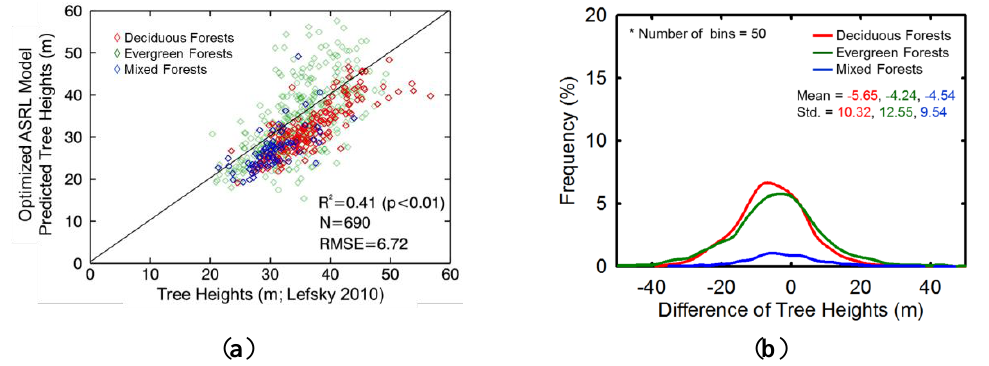
Figure 8. Inter-comparison of tree heights predicted by the optimized ASRL model with tree heights from Lefsky [2]: ( a ) Comparison for each of the climatic zones ( H H ). ( b ) Pixel level difference histograms ( H Lefsky considered in this study. Number of bins of histograms is 50. Frequencies have been normalized by total grids (frequency